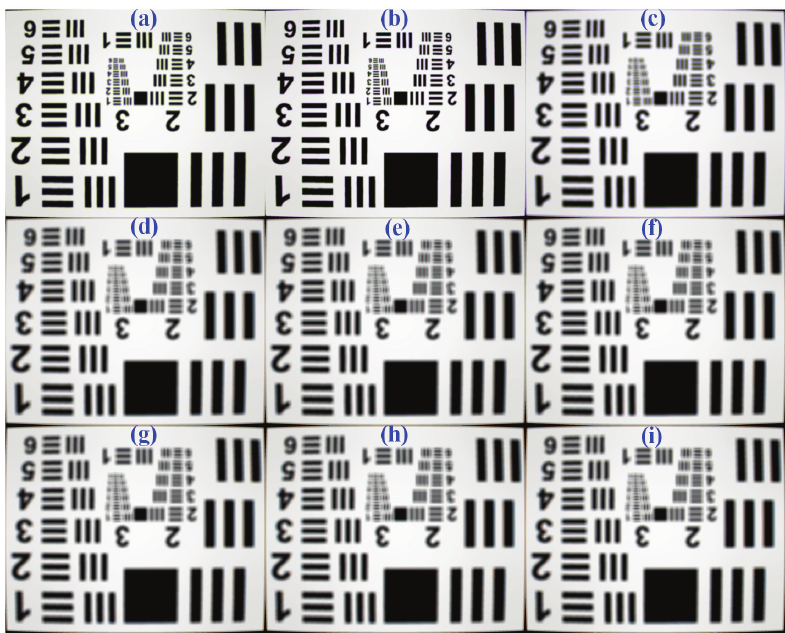
Figure 10. Imaging results of initial optical endoscope in different objective distances. ( a ) 1.8 mm.